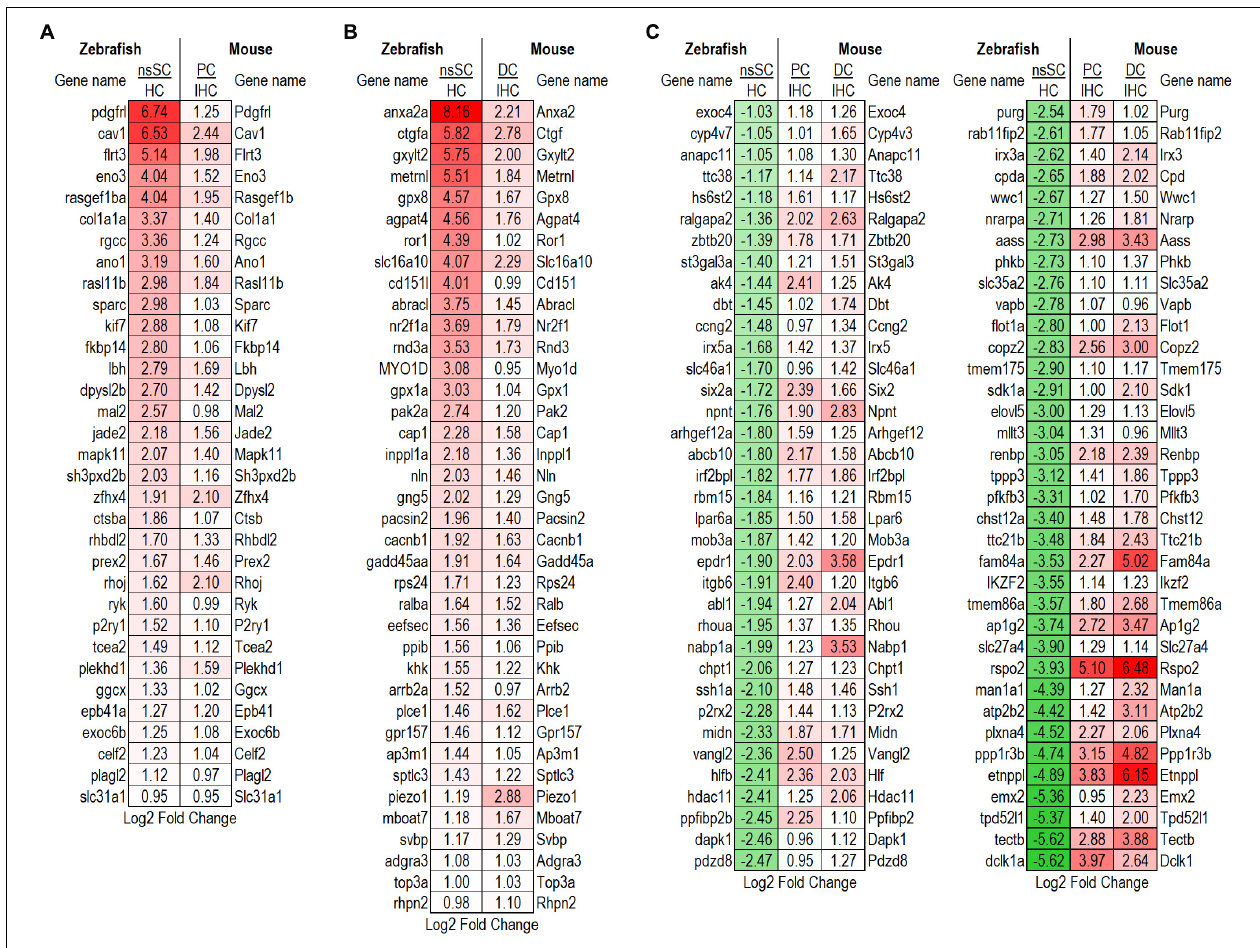
FIGURE 4 | Differentially expressed high-confidence gene orthologs among supporting cells. (A) Log2 fold change values for the 33 high-confidence, out of the 121 total, gene orthologs commonly upregulated by zebrafish nsSCs and PCs. (B) Log2 fold change values for the 38 high-confidence, out of the 148 total, gene orthologs commonly upregulated by zebrafish nsSCs and DCs. (C) High-confidence orthologs downregulated in zebrafish nsSCs, compared to HCs, that were upregulated in mouse PCs or DCs compared to IHCs ( n =